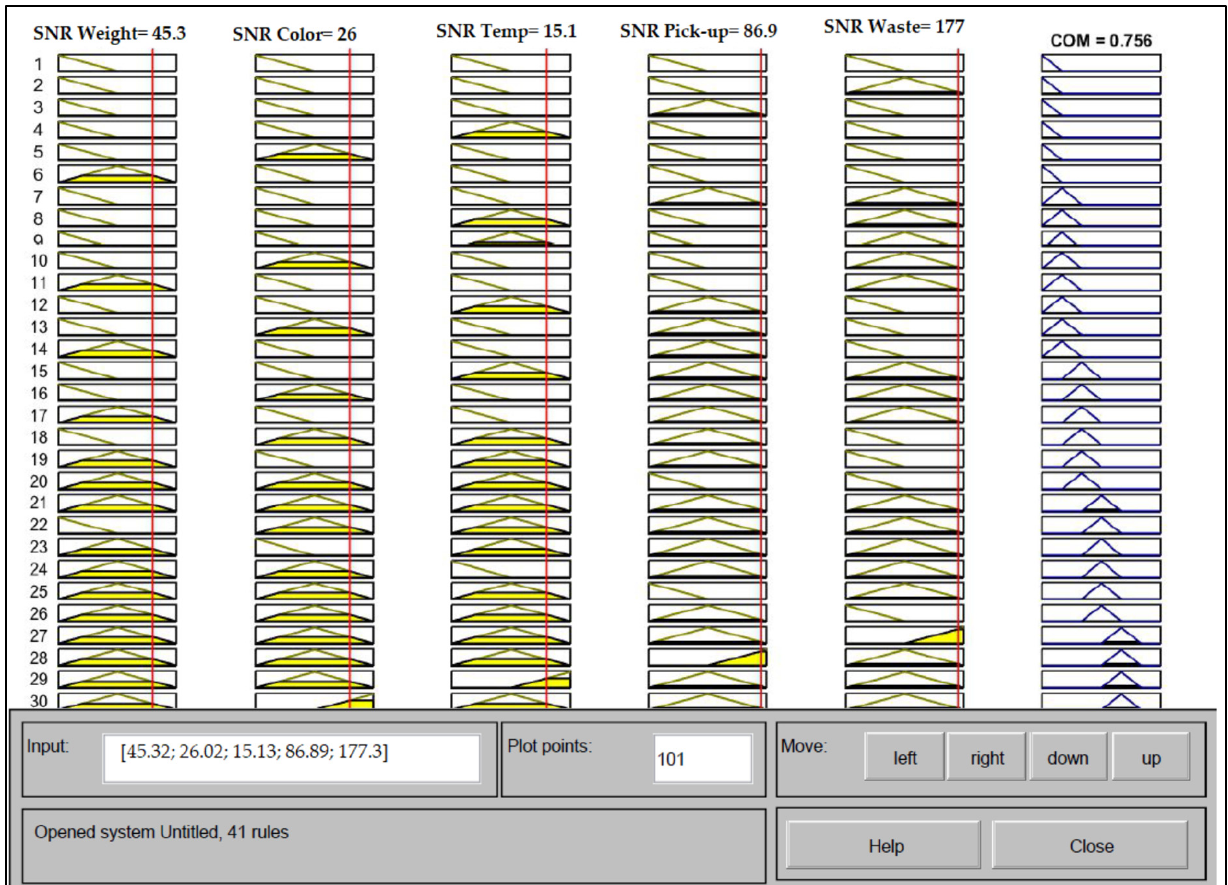
Figure 8. Rules aggregation in the fuzzy system. Table 13. The COM value at each experimental condition.